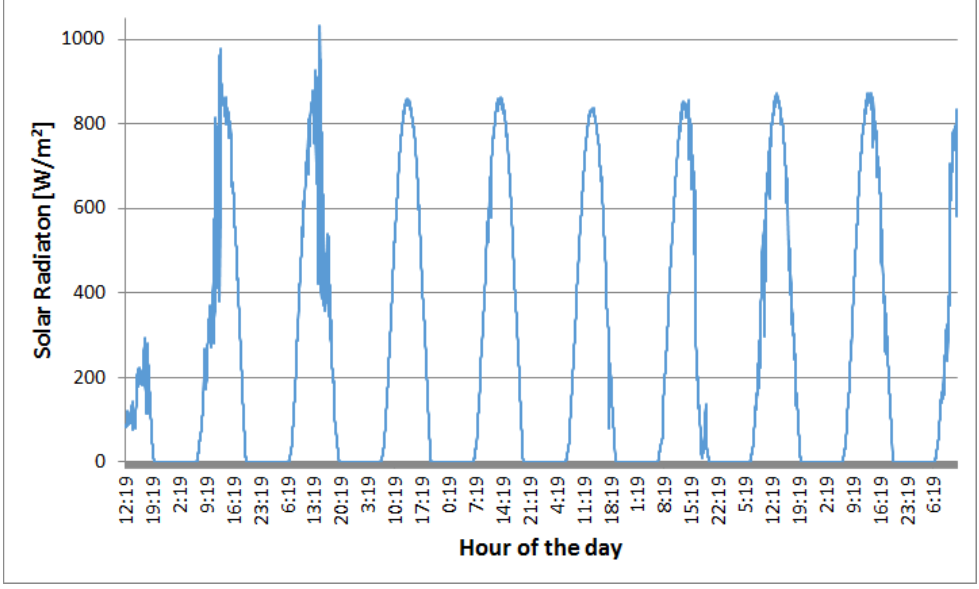
Figure 4. Solar irradiance during the first monitoring